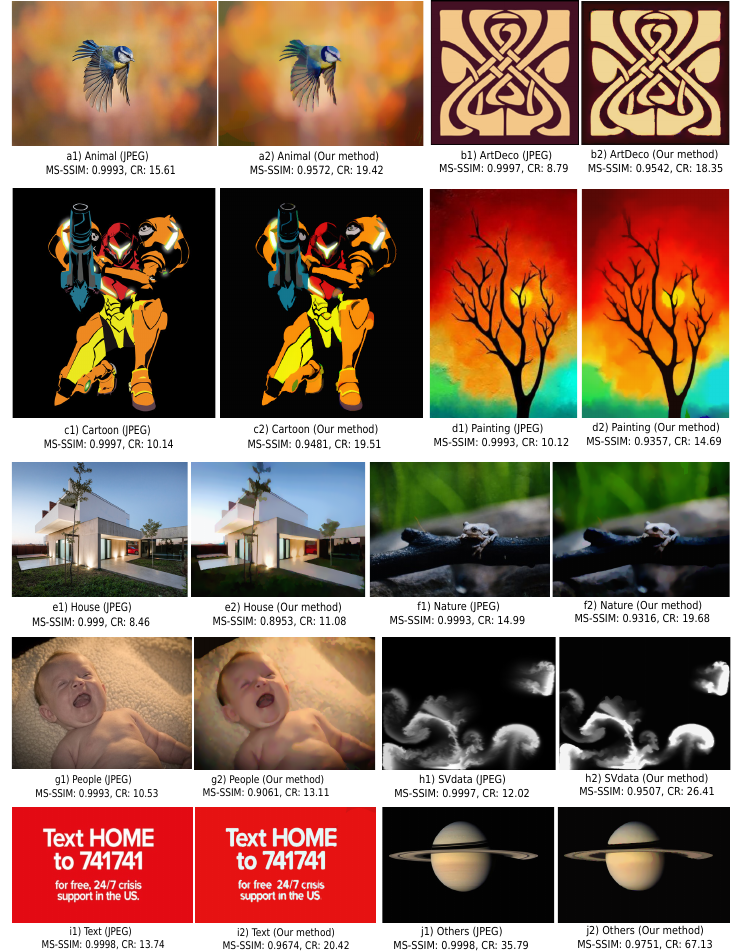
Figure 9. Comparison of JPEG ( a1 – j1 ) with our method ( a2 – j2 ) for 10 image types. For each image, we show the MS-SSIM quality and compression ratio CR